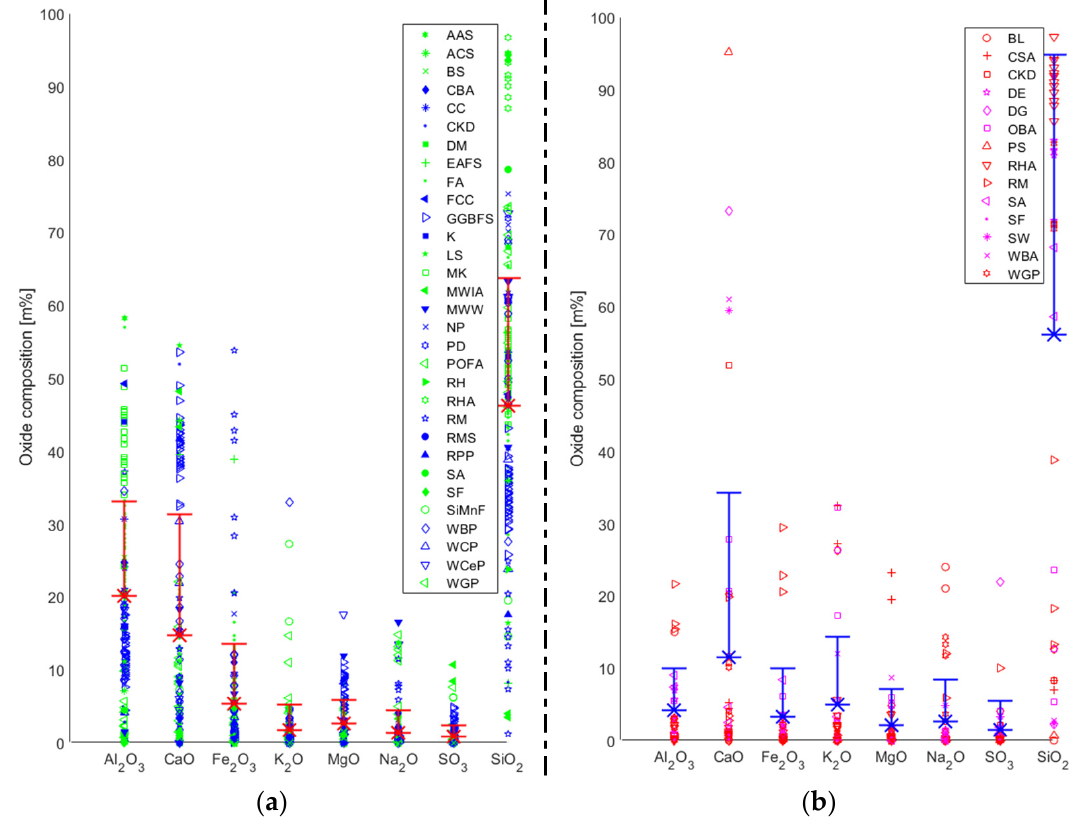
Figure 1. Chemical composition of ( a ) precursors and ( b ) alternative alkali activators.